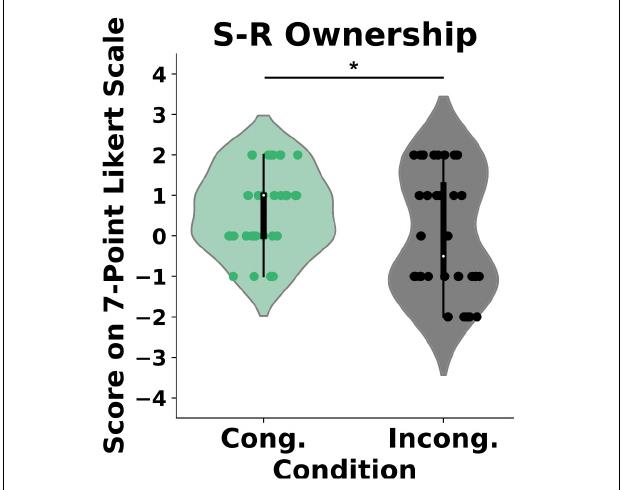
FIGURE 2 | Self-reported experience of ownership. Y -axis: Responses on the 7-point Likert scale ranging from “ − 3” (strongly disagree) to “3” (strongly agree). Scores above “0” indicate a feeling of body ownership. * P <